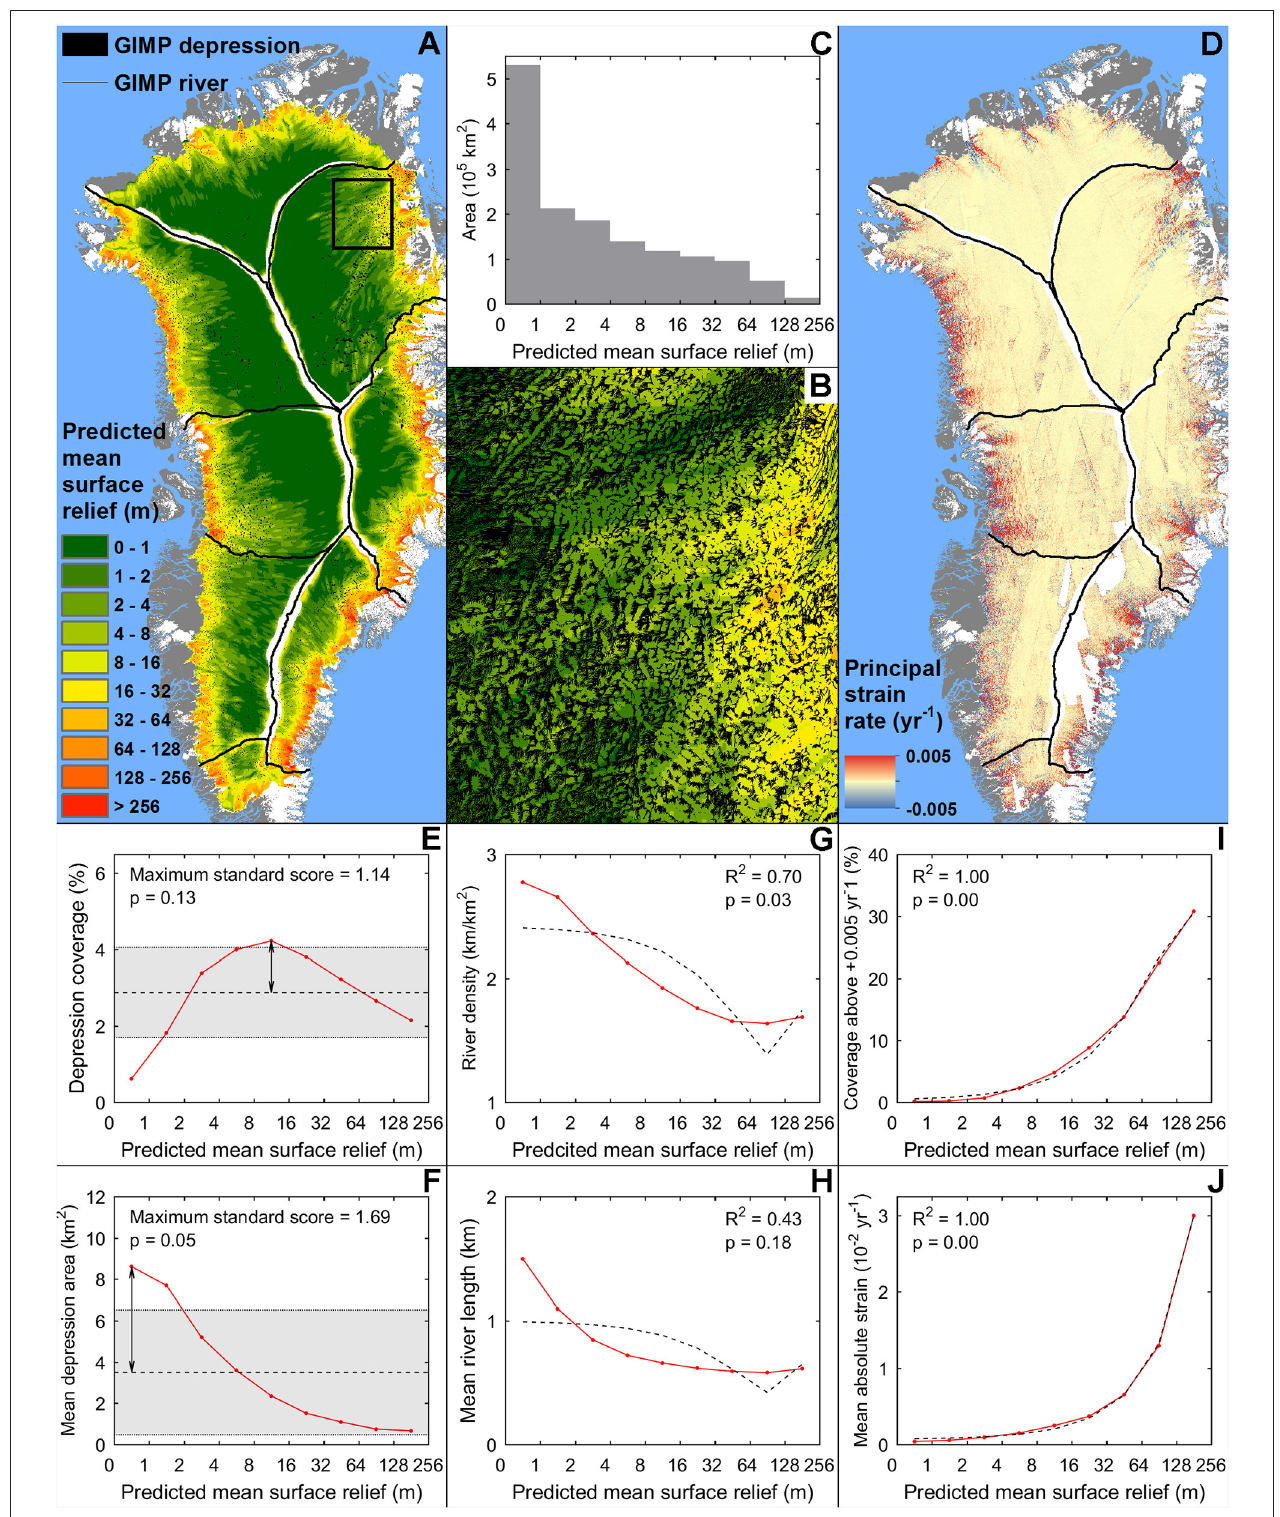
FIGURE 11 | (A) Predicted mean surface relief map compared with the distribution of GIMP-DEM derived closed surface depressions of the whole ice sheet (B) and GIMP-DEM derived rivers of NE Greenland. (C) Area covered by the predicted mean surface relief categories of the GrIS is also shown; categories smaller than 4,500 km 2 have been removed. (D) The ice sheet wide principal strain rate is shown as well. (E) The coverage (F) and mean area of the GIMP-DEM derived depressions